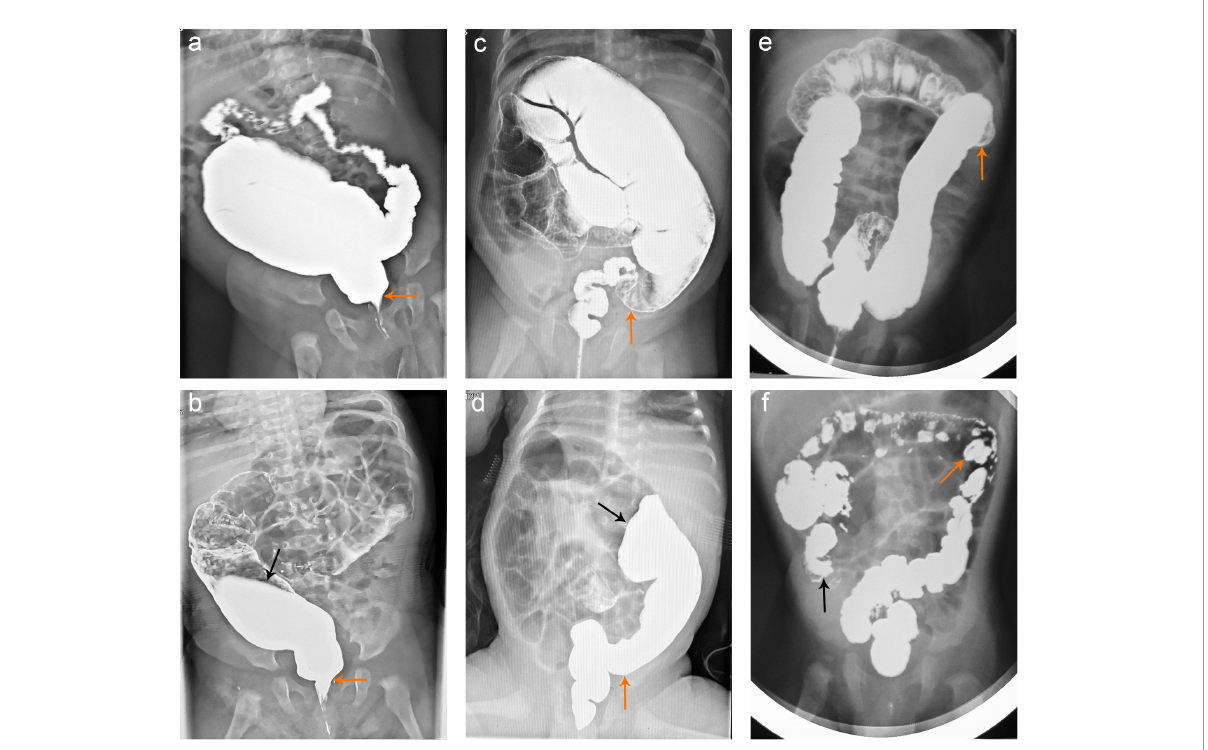
FIGURE2 Barium enema findings in HSCR patients. (a,b) The barium enema demonstrated the TZ (yellow arrows) and dilated colon in a 6-month-old boy with short-segment HSCR. The 24-h delayed film revealed that the barium enema was retained up to the descending colon (black arrow). (c,d) The TZ characterized by barium enema was shown with yellow arrows in a 4-month-old boy with classical type HSCR, and the barium enema was retained up to the transverse colon (black arrow) in the 24-h delayed film. (e,f) TZ in an 8-month-old girl having long-segment HSCR was described by barium enema (yellow arrows). The 24-h delayed film indicated that the barium enema was retained up to the cecum (black arrows). HSCR, Hirschsprung’s disease; TZ, transition zone.